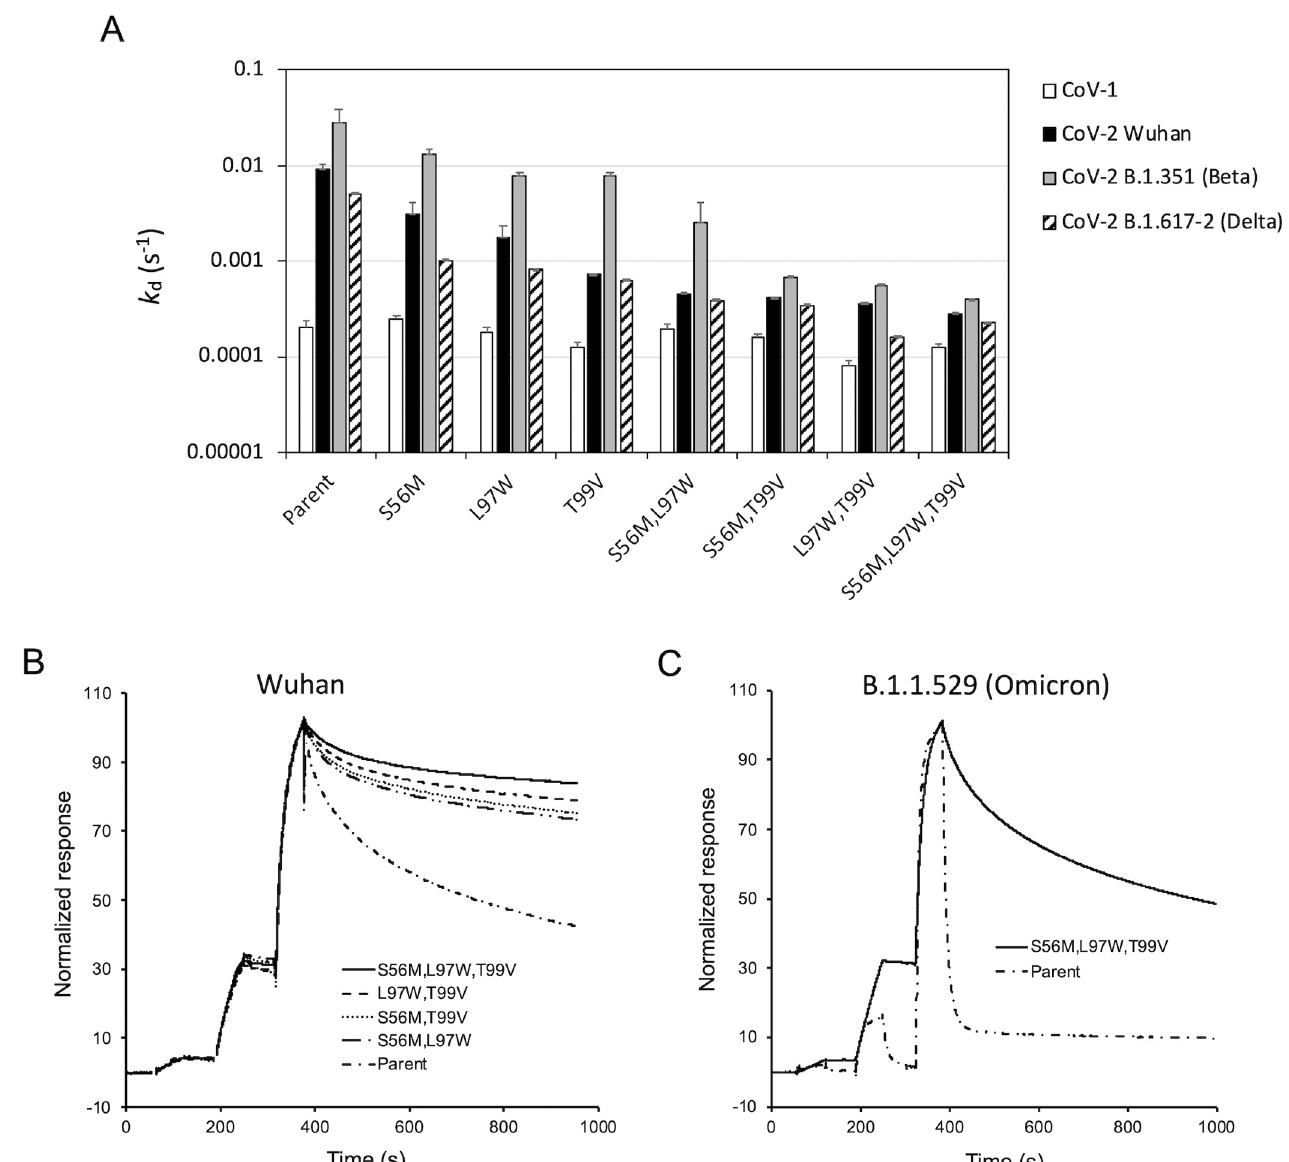
Fig 2. Biophysical testing of VHH-72-Fc mutant hits. ( A ) Dissociation rates ( k d ) determined by SPR for the three single-mutant hits and resulting multiple mutants, for binding to immobilized spike RBDs from SARS-CoV-1, SARS-CoV-2 Wuhan, SARS-CoV-2 B.1.351 (Beta) and SARS-CoV-2 B.1.617.2 (Delta). ( B ) Overlaid SPR sensorgrams for the parental variant and the four multiple mutants against immobilized SARS-CoV-2 Wuhan spike RBD. ( C ) Overlaid SPR sensorgrams for the parental variant and the triple mutant against immobilized SARS-CoV-2 B.1.1.529 (Omicron) spike RBD. See also S3 Fig for representative sensorgrams and modeled binding